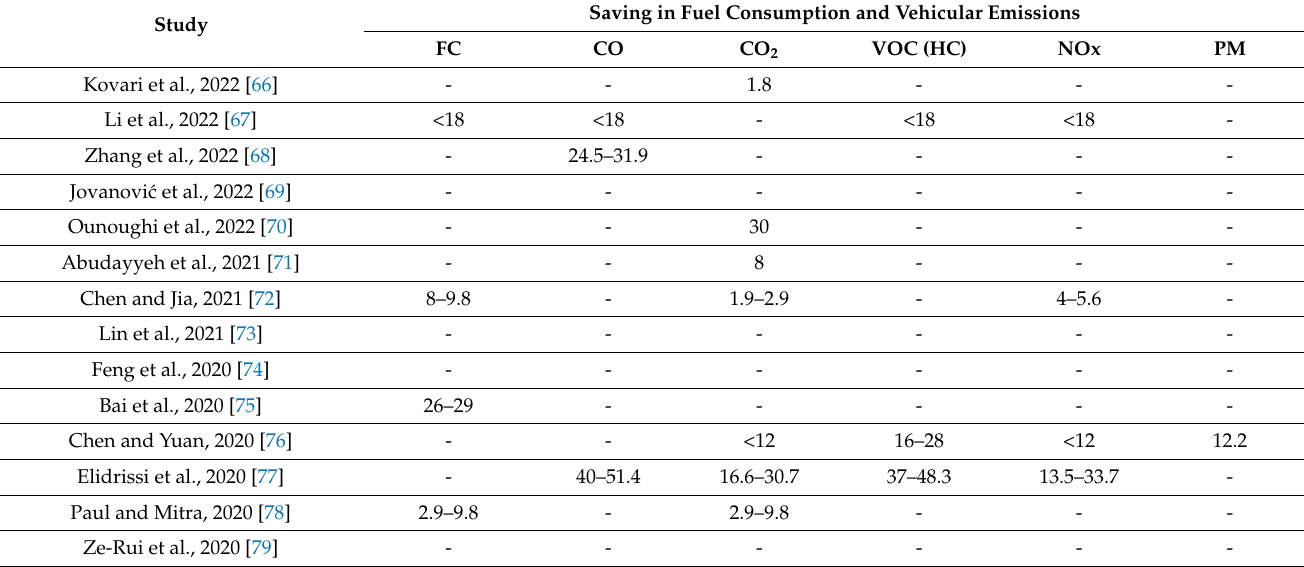
Table 2. Saving (%) in sustainability metrics as documented by various